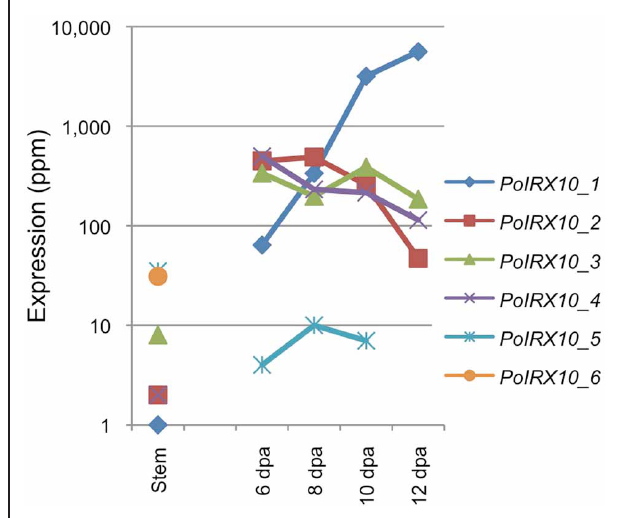
FIGURE 2 | Expression levels of IRX10 homologs in psyllium in stem and mucilaginous